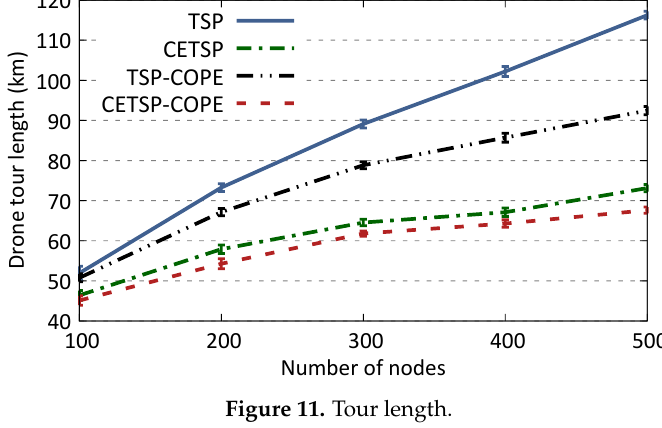
Figure 11. Tour length.